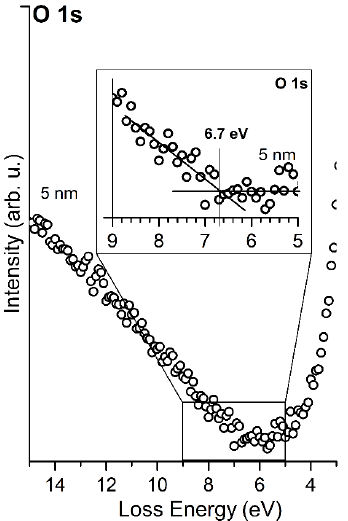
Figure 3. XPS spectra of Mg 2p and O 1s core level lines for bare SiC(0001) surface and covered with MgO layers of an average thickness of 3 and 5 nm. The peak positions correspond to the MgO compound and remain in the same binding energies regardless of the thickness.